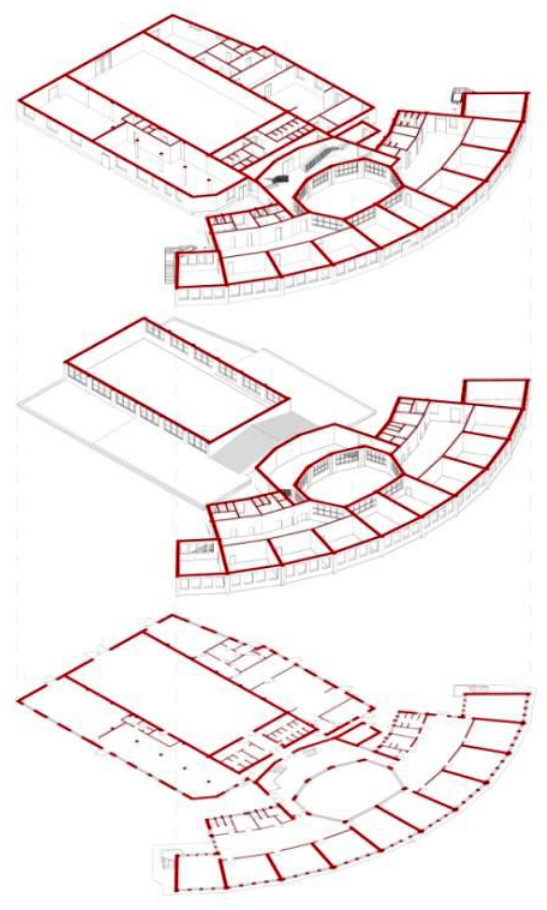
Figure 17. Axonometric sections of the Borgomarino